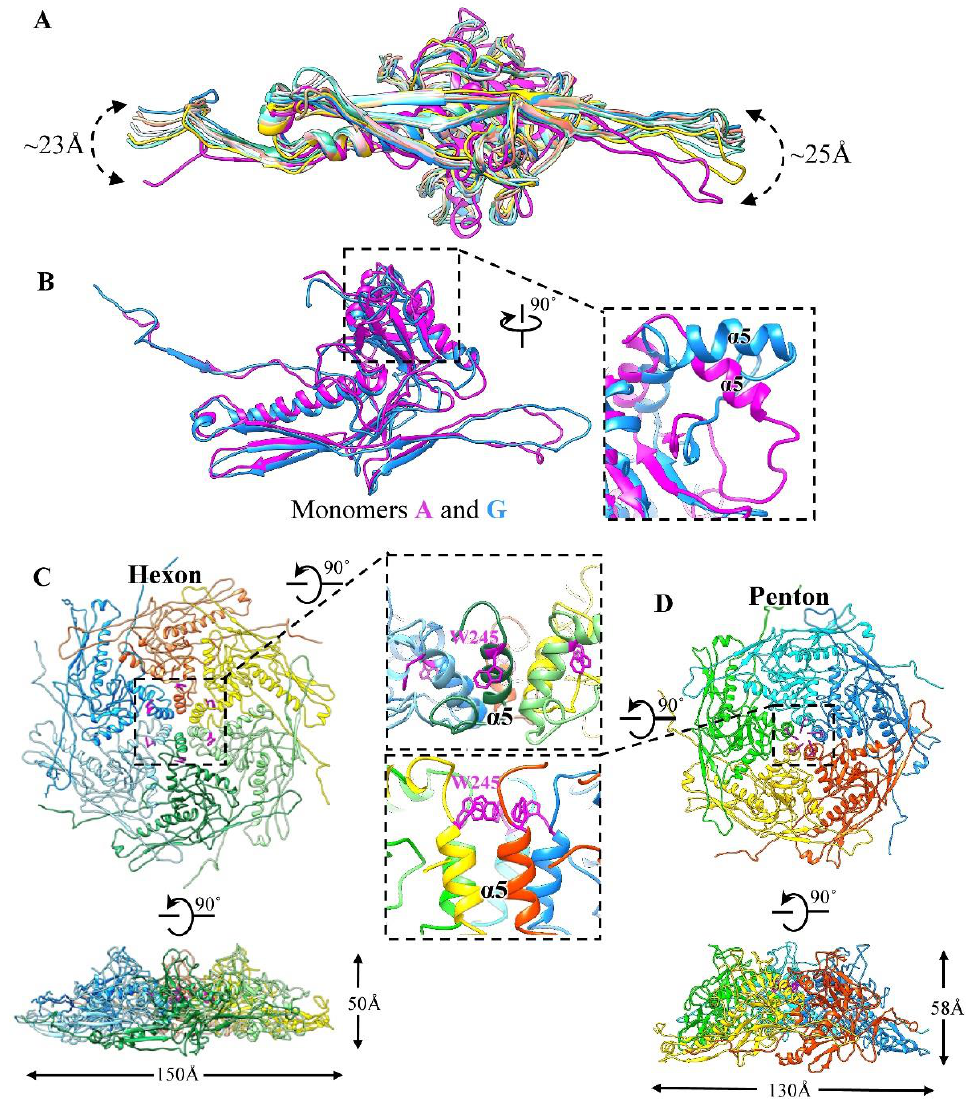
Figure 2. Structure of MCPs. ( A ) Superimposition of the nine MCPs with different colors showing global conformational changes. ( B ) Superimposition of monomers A and G with the same color schedule but a different view to ( A ). The inset is a zoom-in view of the conformational changes of α5 (residues 230–278) in the A-domain. ( C , D ) The hexon and penton (six and five subunits in different colors) are shown along the top and the side views, respectively. The inset is a zoom-in view of the local region of the hexon/penton A-domains where the side chains of residue W245 (magenta) are shown as stick models.